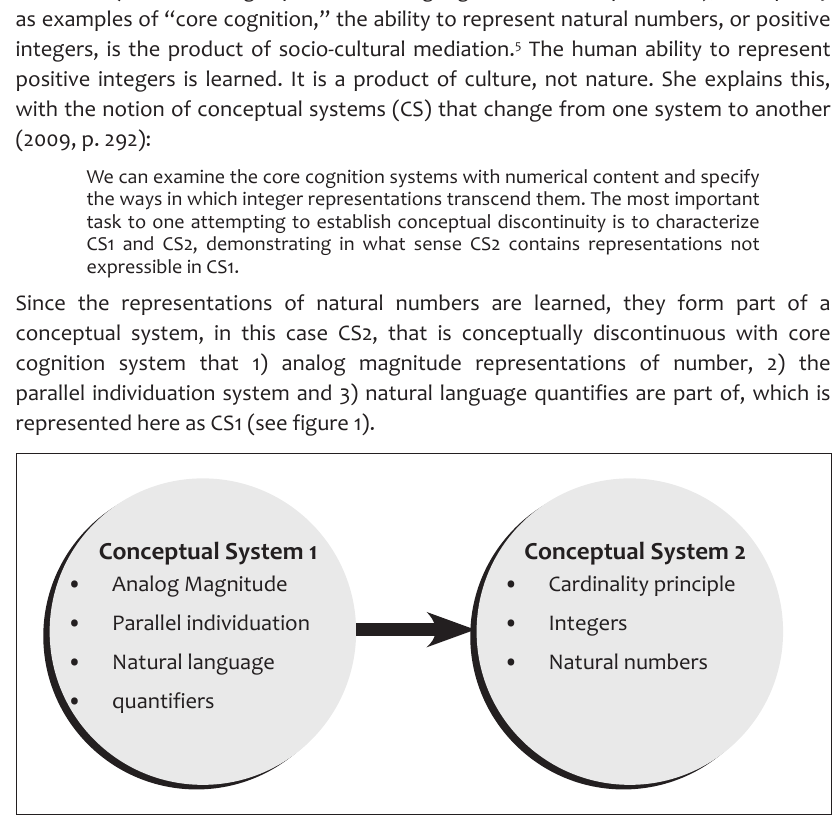
Figure 1: The conceptual representation of